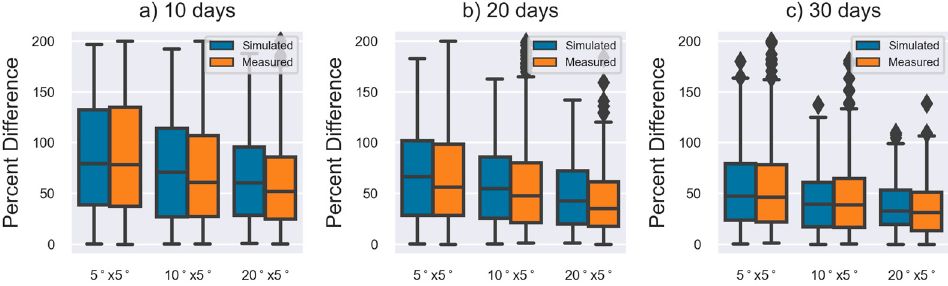
Figure 8. Orange box and whisker plots represent the measured PD distributions between B4 and CloudSat estimates of ∆ SWE for 10 day ( a ), 20 day ( b ), and 30 day ( c ) time periods. Simulated PD distributions from Figure 4 are provided for comparison in